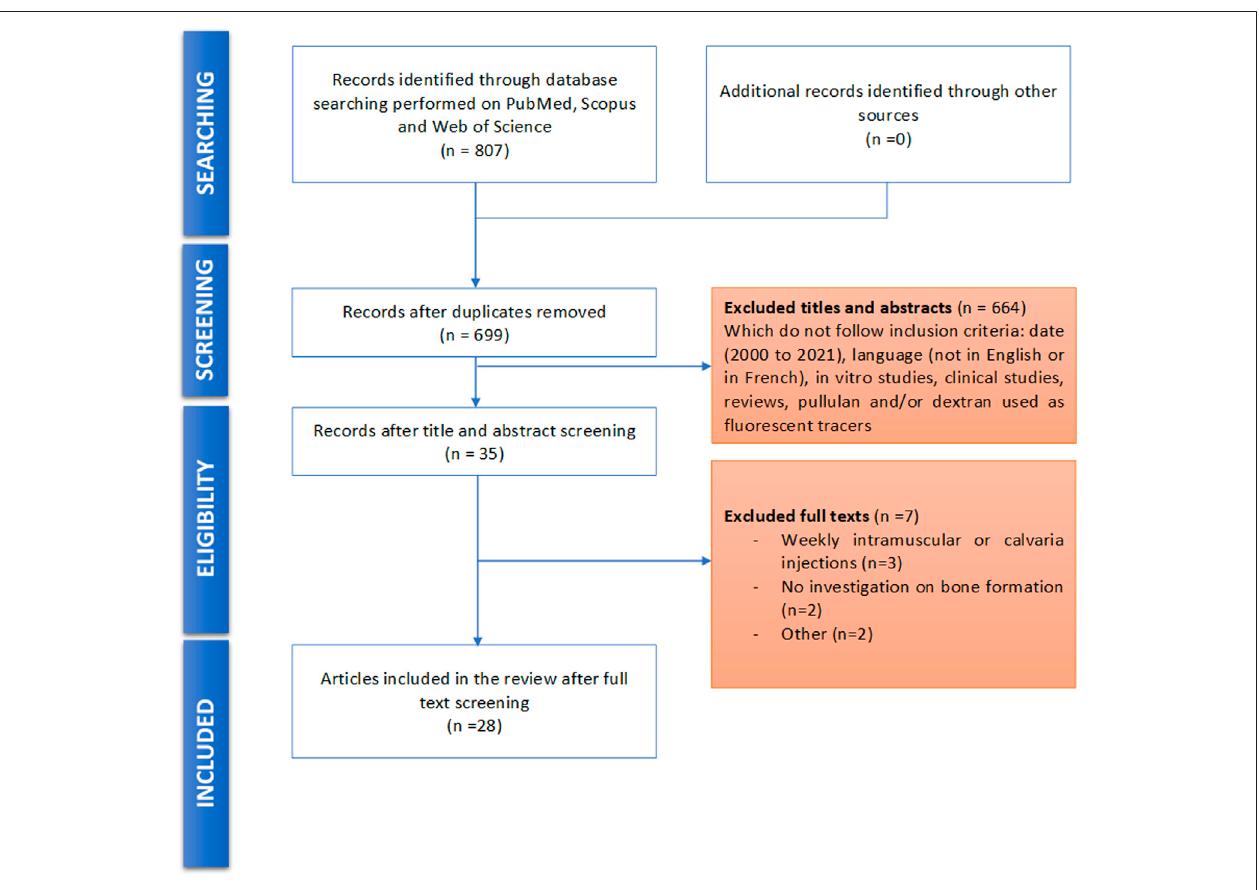
FIGURE 1 | Flow diagram of the screened